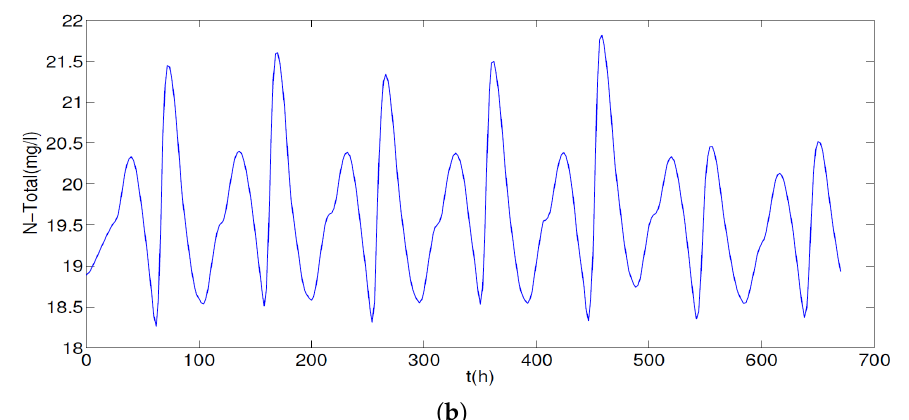
Figure 7. Ammonium and total nitrogen concentration under the proposed controller. ( a ) Ammonium concentration NH 2 , ( b ) Total Nitrogen N − Total .